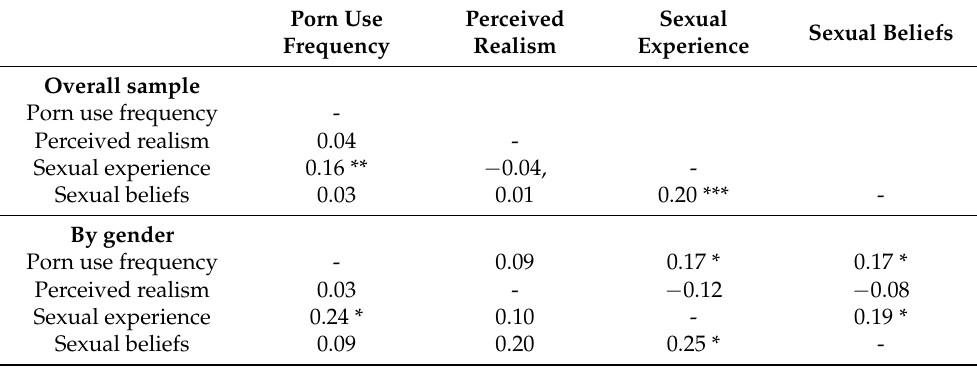
Table 3. Zero-order correlations between pornography use frequency, perceived realism, sexual experience, and porn-congruent sexual health beliefs among the overall sample and broken down by gender (with females reported above the diagonal and male reported